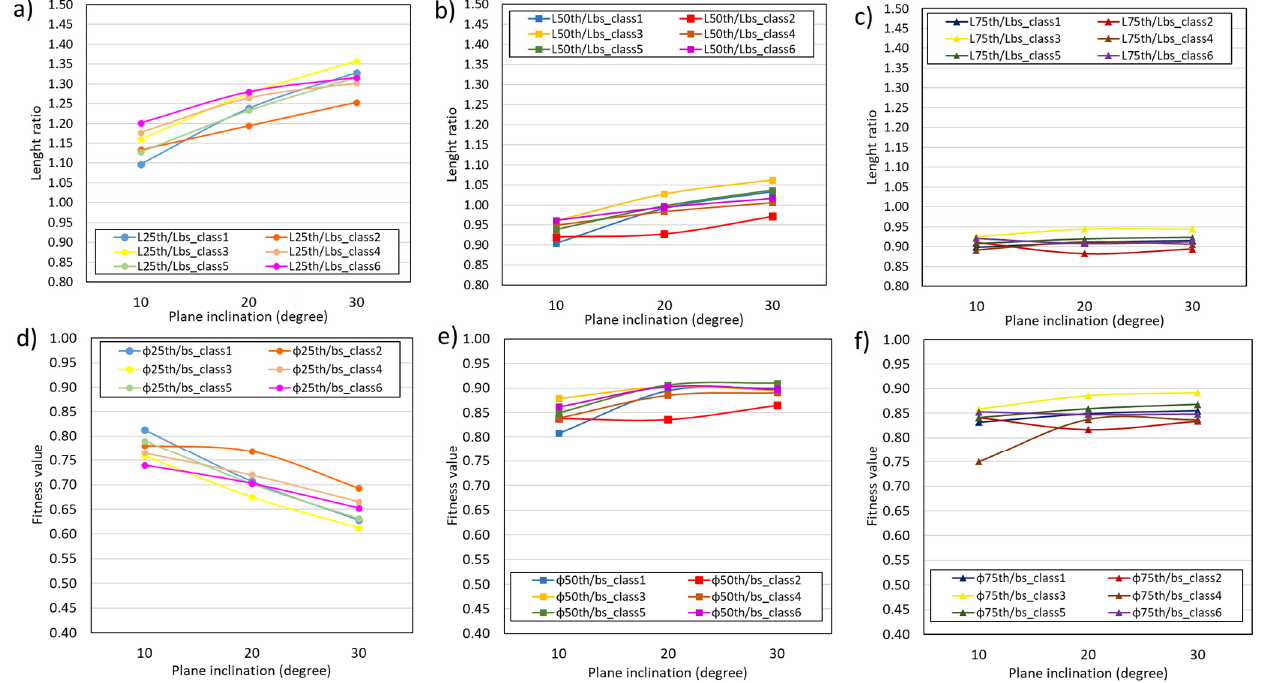
Figure 10. Diagrams showing the length ratios L ( a – c ) and fitness values ϕ ( d – f ) between the simulated lava derived from the characteristic curves and bell-shaped (bs) curves on all of the inclined planes (10°, 20°, 30°). Calculations were performed to compare the 25th curves (circles), 50th (square), and 75th curves (triangles) with the bell-shaped curves for each eruptive class.